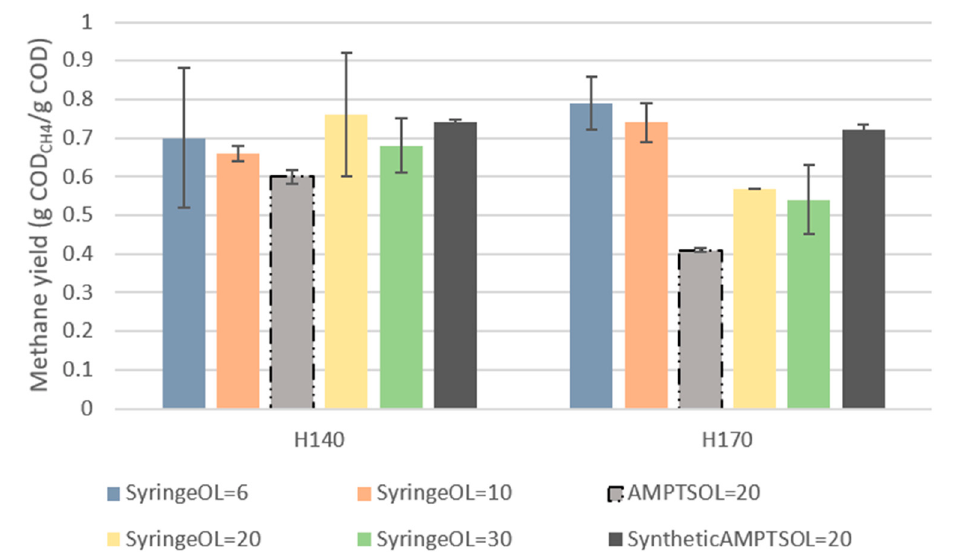
Figure 4. Methane yield of H140 and H170 at different organic loads (OLs) in syringes. Yields from AMPTS II is also added for comparison. COD = chemical oxygen demand.